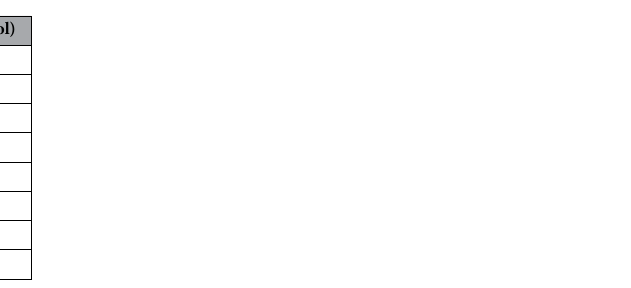
Table 3. Docking scores of the active ingredients of ginseng leaves with their potential